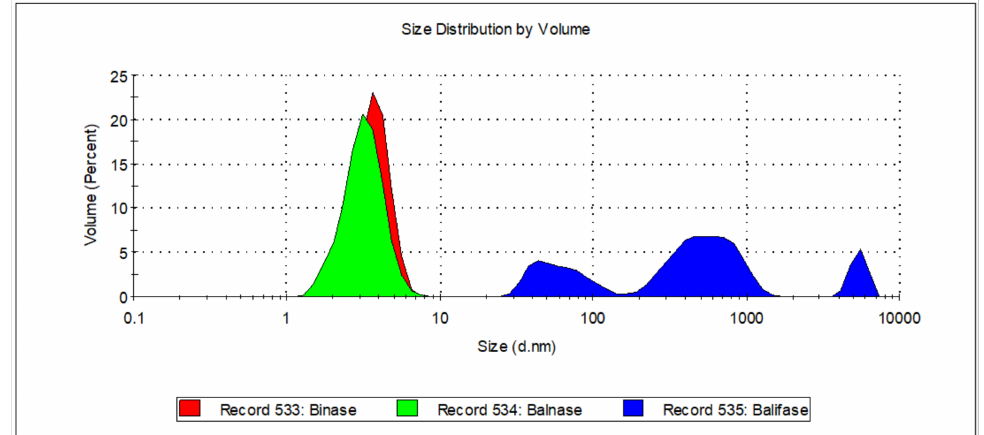
Figure 3. The size of RNase molecules in solution.